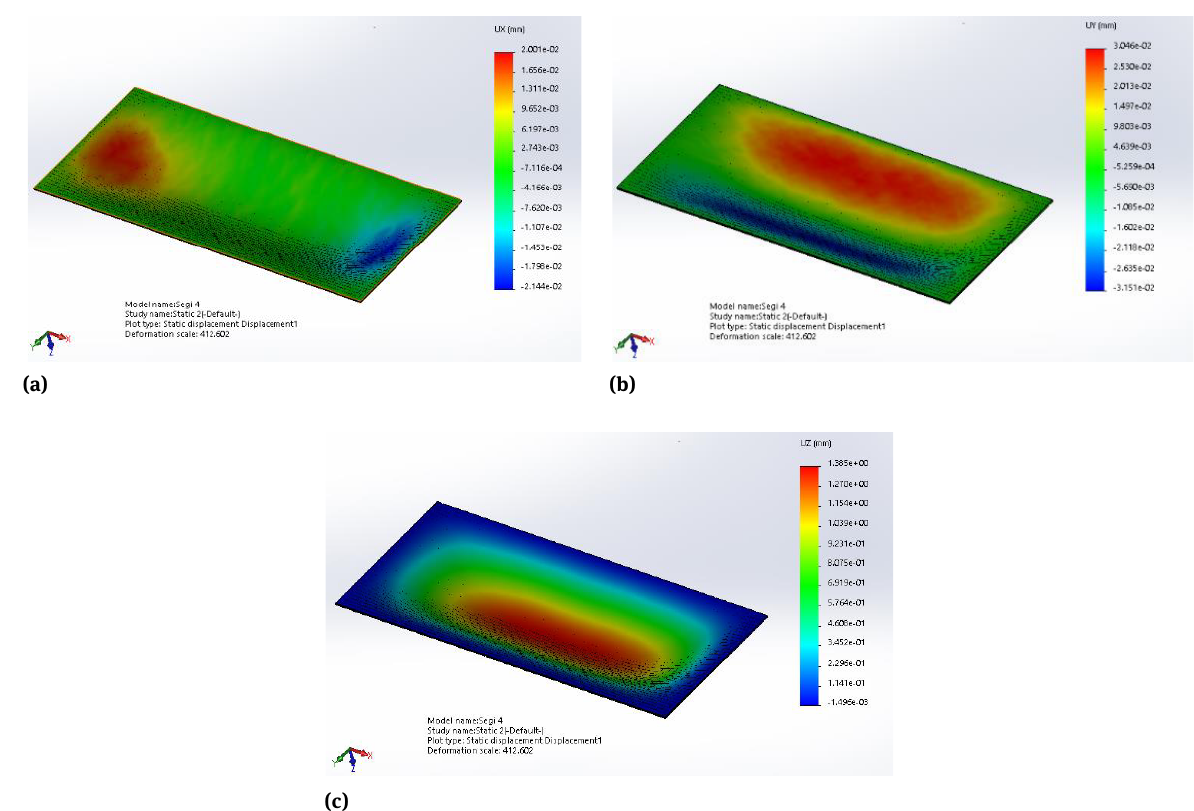
Figure 17: Displacement of the square honeycomb in the static simulation: (a) x-axis, (b) y-axis, (c) z-axis